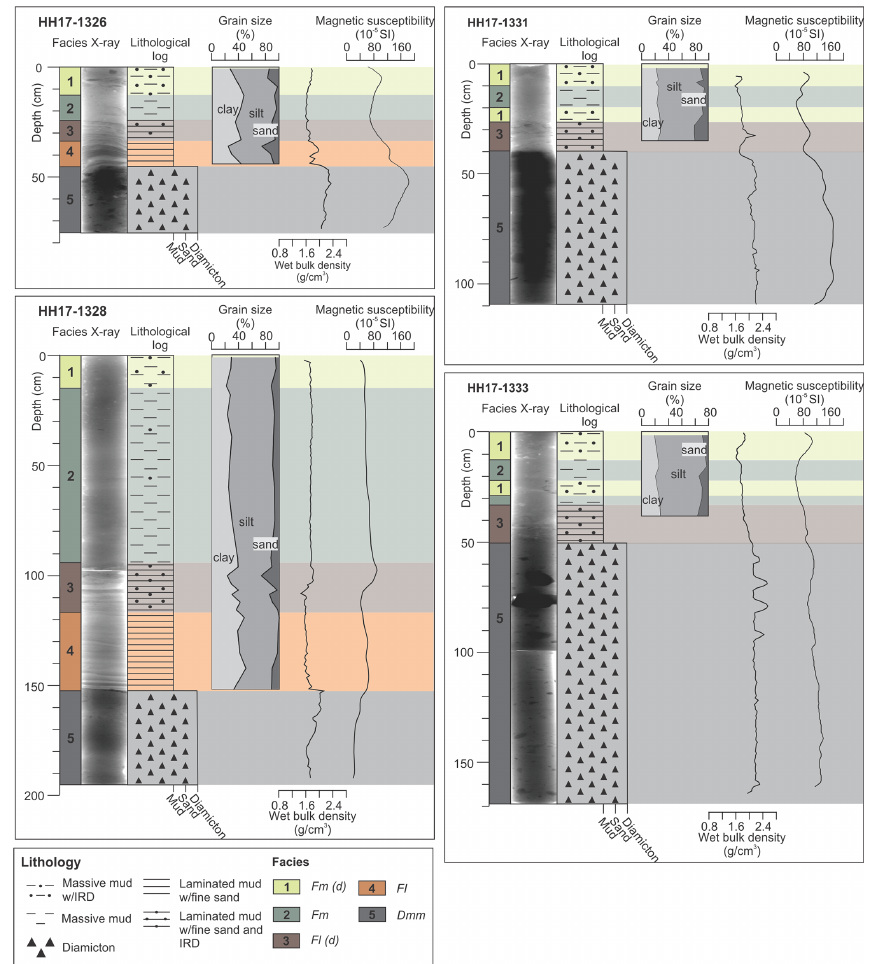
Figure 2. Lithofacies logs, X-radiographs, grain-size distribution and physical properties for the cores from the inner and middle Store Koldewey Trough. The darker grey tones in the X-radiographs reflect higher density, whereas brighter grey tones reflect lower density. The locations of the sediment cores are shown in Fig.